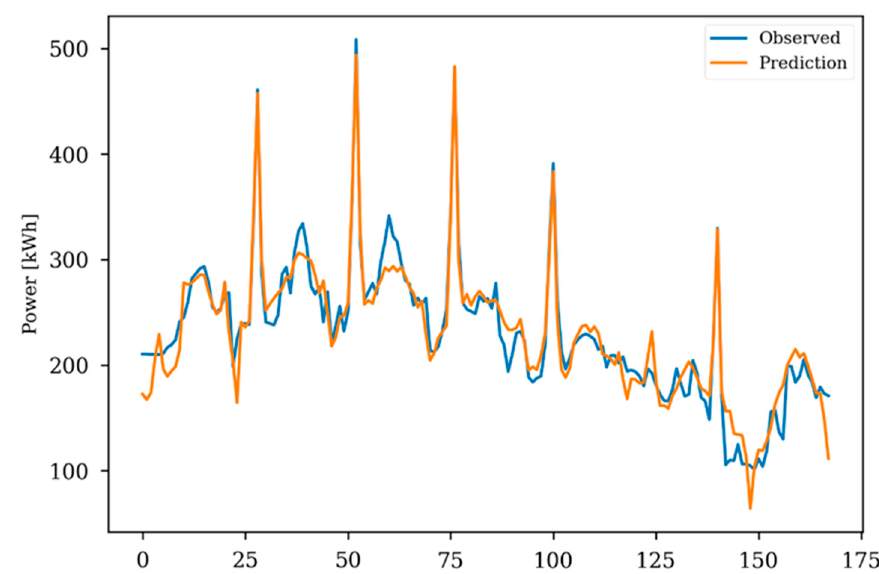
Figure 10. Prediction of refrigeration-unit power consumption.